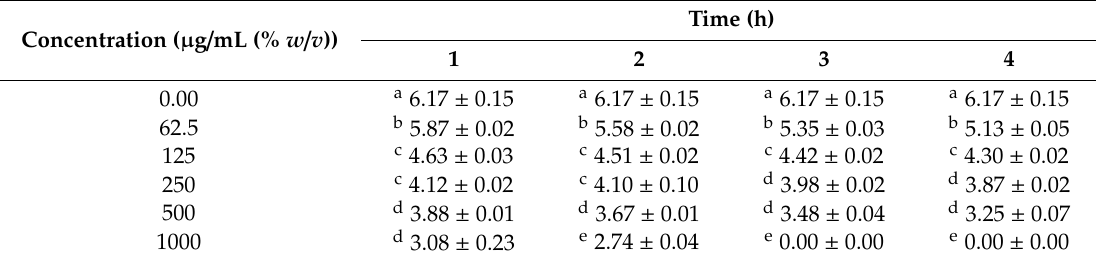
Table 4. The sporicidal activity of β -asarone against the spores of B. subtilis ATCC6633. Concentration ( µ g / mL (% w / v ))